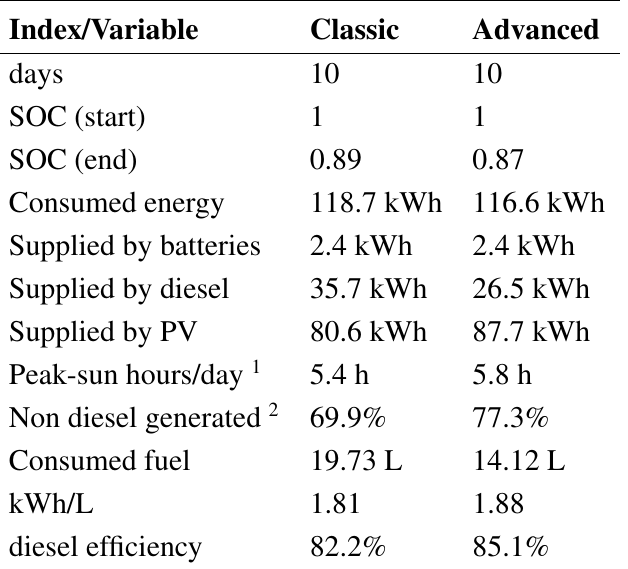
Table 2. Simulation